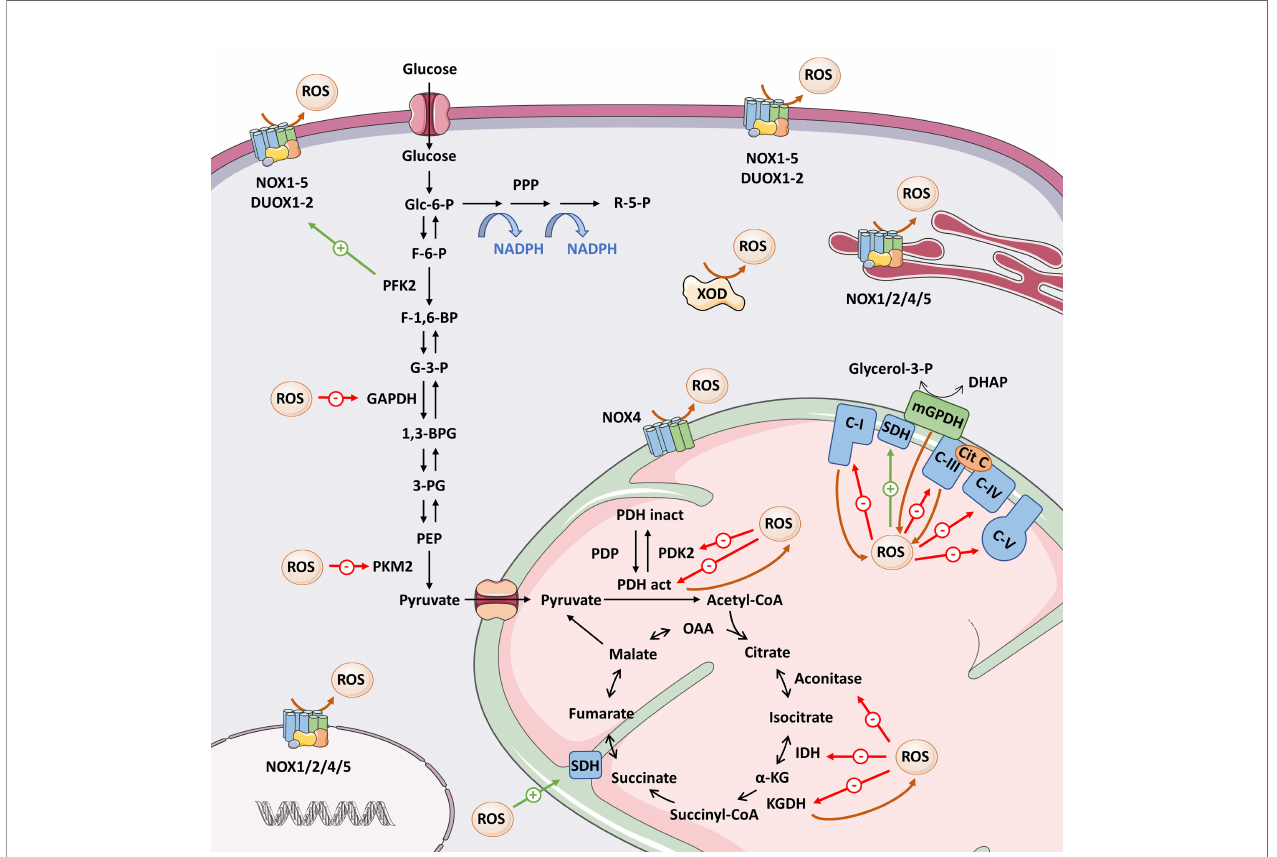
FIGURE 3 | Overview of the interrelationship between ROS and metabolic enzymes. Here we present the main ROS-producing systems, as well as the metabolic enzymes whose activity is modi fi ed by direct oxidation (see text for details). Brown arrows mean ROS production; red arrows mean inhibition; green arrows mean activation of target. 1,3-BPG, 1,3-bisphosphoglycerate; 3-PG, 3-phosphoglycerate; Cit C, cytochrome C; DHAP, dihydroxyacetone phosphate; F-1,6-BP, fructose- 1,6-bisphosphate; F-6-P, fructose-6-phosphate; G-3-P, glyceraldehyde-3-phosphate; GAPDH, glyceraldehyde-3-phosphate dehydrogenase; Glc-6-P, glucose-6- phosphate; IDH, isocitrate dehydrogenase; a -KG, a -ketoglutarate; KGDH, a -ketoglutarate dehydrogenase; mGPDH, mitochondrial a -glycerophosphate dehydrogenase; OAA, oxaloacetate; PDH act, pyruvate dehydrogenase complex active; PDH inact, pyruvate dehydrogenase complex inactive; PDK2, pyruvate dehydrogenase kinase 2; PDP, pyruvate dehydrogenase phosphatase; PEP, phosphoenolpyruvate; PFK2, phosphofructokinase 2; PKM2, pyruvate kinase M2; PPP, pentose phosphate pathway; R-5-P, ribose 5-phosphate; ROS, reactive oxygen species; SDH, succinate dehydrogenase; XOD, xanthine